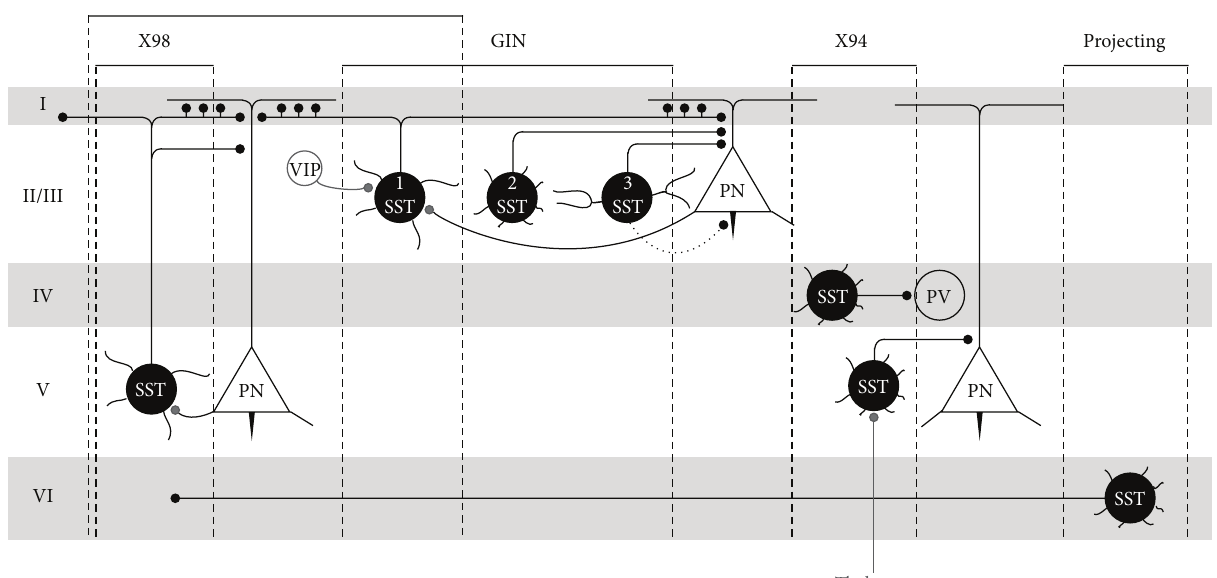
Figure 1: SST-interneurons labeled in X98-, GIN-, and X94-transgenic mice have distinct laminar distributions and wiring patterns. X98- SST-interneurons mainly reside in infragranular layer V whereas the GIN-SST-interneuron subpopulation 1 mainly resides in supragranular layer II/III. Both subtypes are considered Martinotti cells due to their layer I dendrite-targeting properties onto layer II/III and V pyramidal neurons. The second and third population of GIN-SST-interneurons avoid layer I but dendritically target pyramidal neurons within layer II/III. GIN-type 2 interneurons are characterized by small, multipolar dendritic arbors, whereas GIN-type 3 interneurons have larger, bitufted dendritic arbors. Some layer II/III GIN-SST-neurons target the axon initial segment of pyramidal neurons. The dotted line denoting this synapse indicates that it is not yet known to which subpopulations this property can be attributed. Layer II/III VIP-interneurons somatically target SST-interneurons within this layer. X94-SST-interneurons reside either in layer IV, where they mainly target fast-spiking PV-interneurons, or in layer V, where they dendritically target layer V pyramidal neurons. Specifically layer V X94-neurons can receive thalamic input, whereas layer IV X94-neurons are intracortically driven. Finally, SST-projecting-neurons are mainly described in layer VI. Thick lines indicate dendritic arbors; thin lines depict axonal projections. Black dots indicate synapses between SST-interneuron dendrites and their targets. Grey dots indicate synapses from the input sources onto